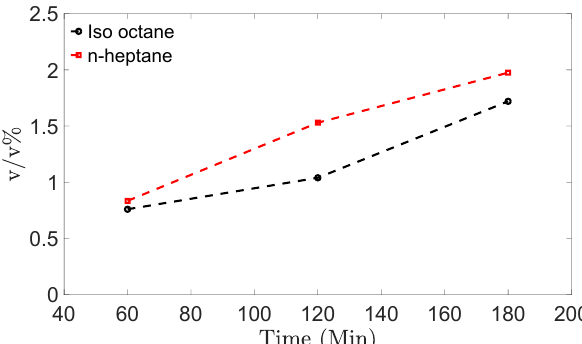
Figure 6. Hexatriene formation as a function of irradiation time.